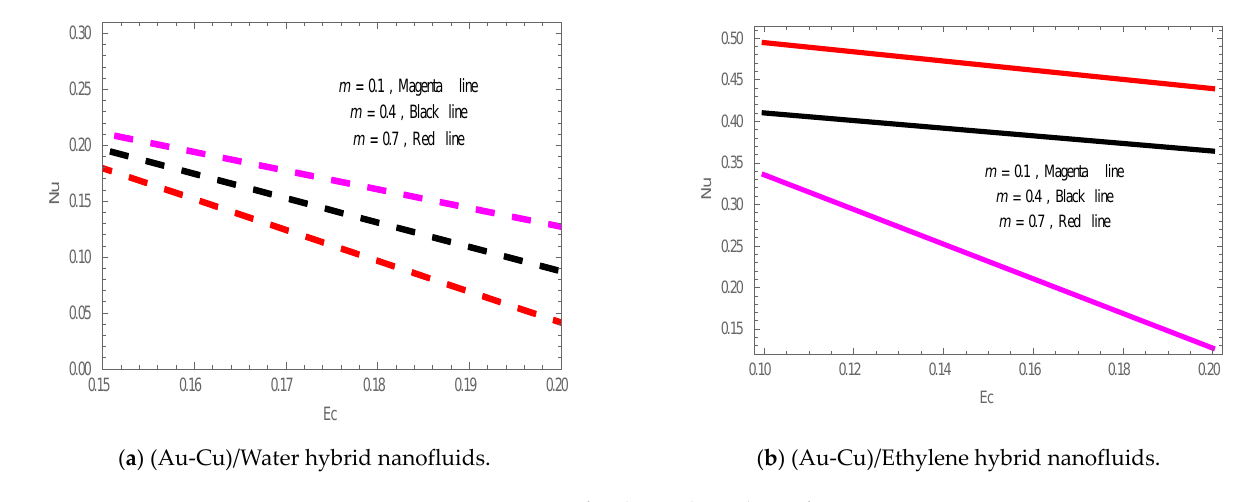
Figure 14. Nu for dissimilar values of R.